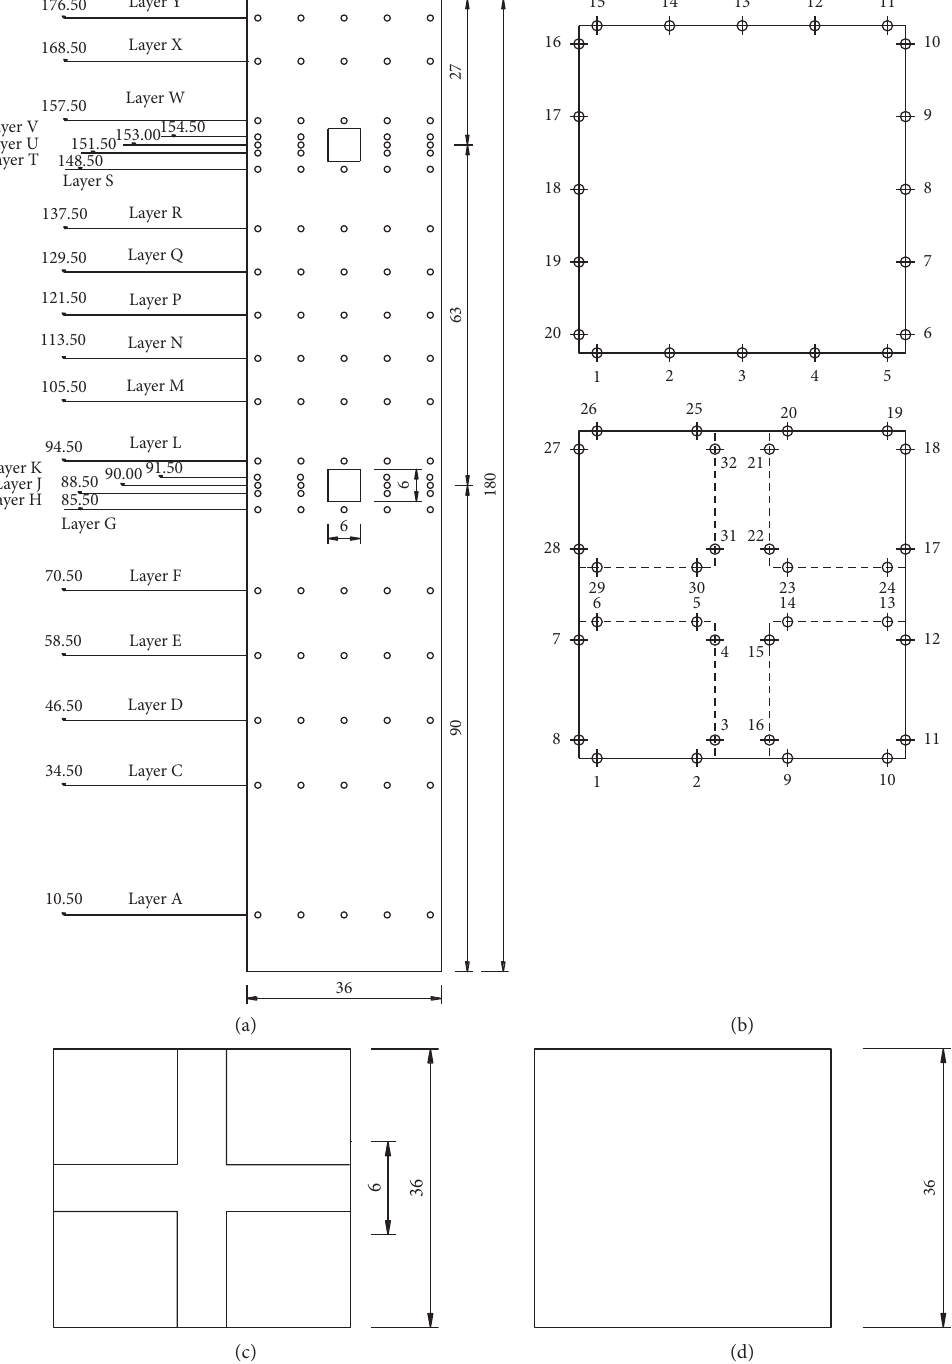
Figure 12: Layout of measuring points and geometric parameters for small opening model. Layout of measuring points on standard layer. (a) Layout of measuring points on facade. (b) Layout of measuring points on the opening layer. (c) Dimensions of small openings. (d) Cross